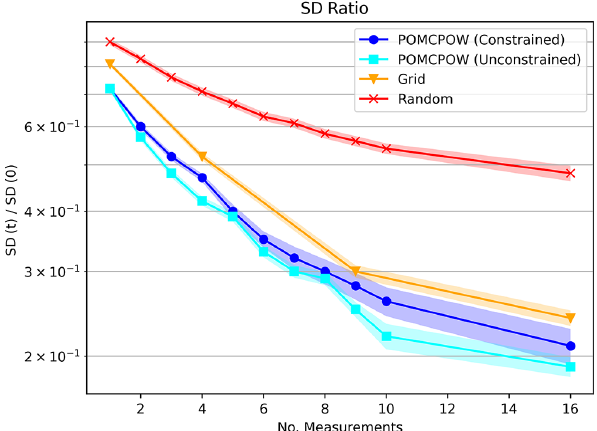
Figure 13. Relative MAE single mineralization, fixed location. The plot shows the mean relative absolute error after a given number of measurements taken under each tested method. The mean absolute error is shown along with 1 standard error bounds for each trend.